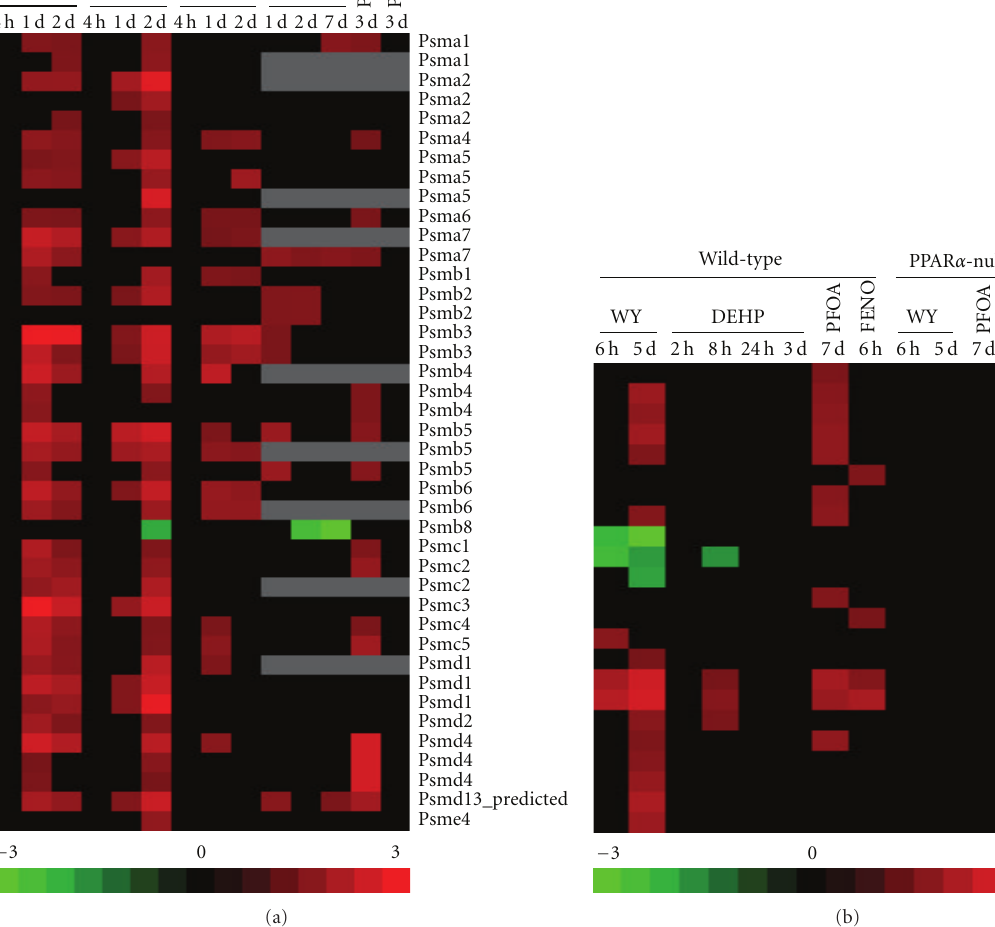
Figure 3: Expression of the proteasomal genes in the rat and mouse liver after PPC treatment. Proteasomal gene expression was examined in the (a) rat liver or (b) mouse liver after PPC exposure using the studies described in Figures 1 and 2. Genes which exhibited altered expression in at least one of the treatments are shown. Genes are presented in alphabetical order. Many genes were represented by more than one probe